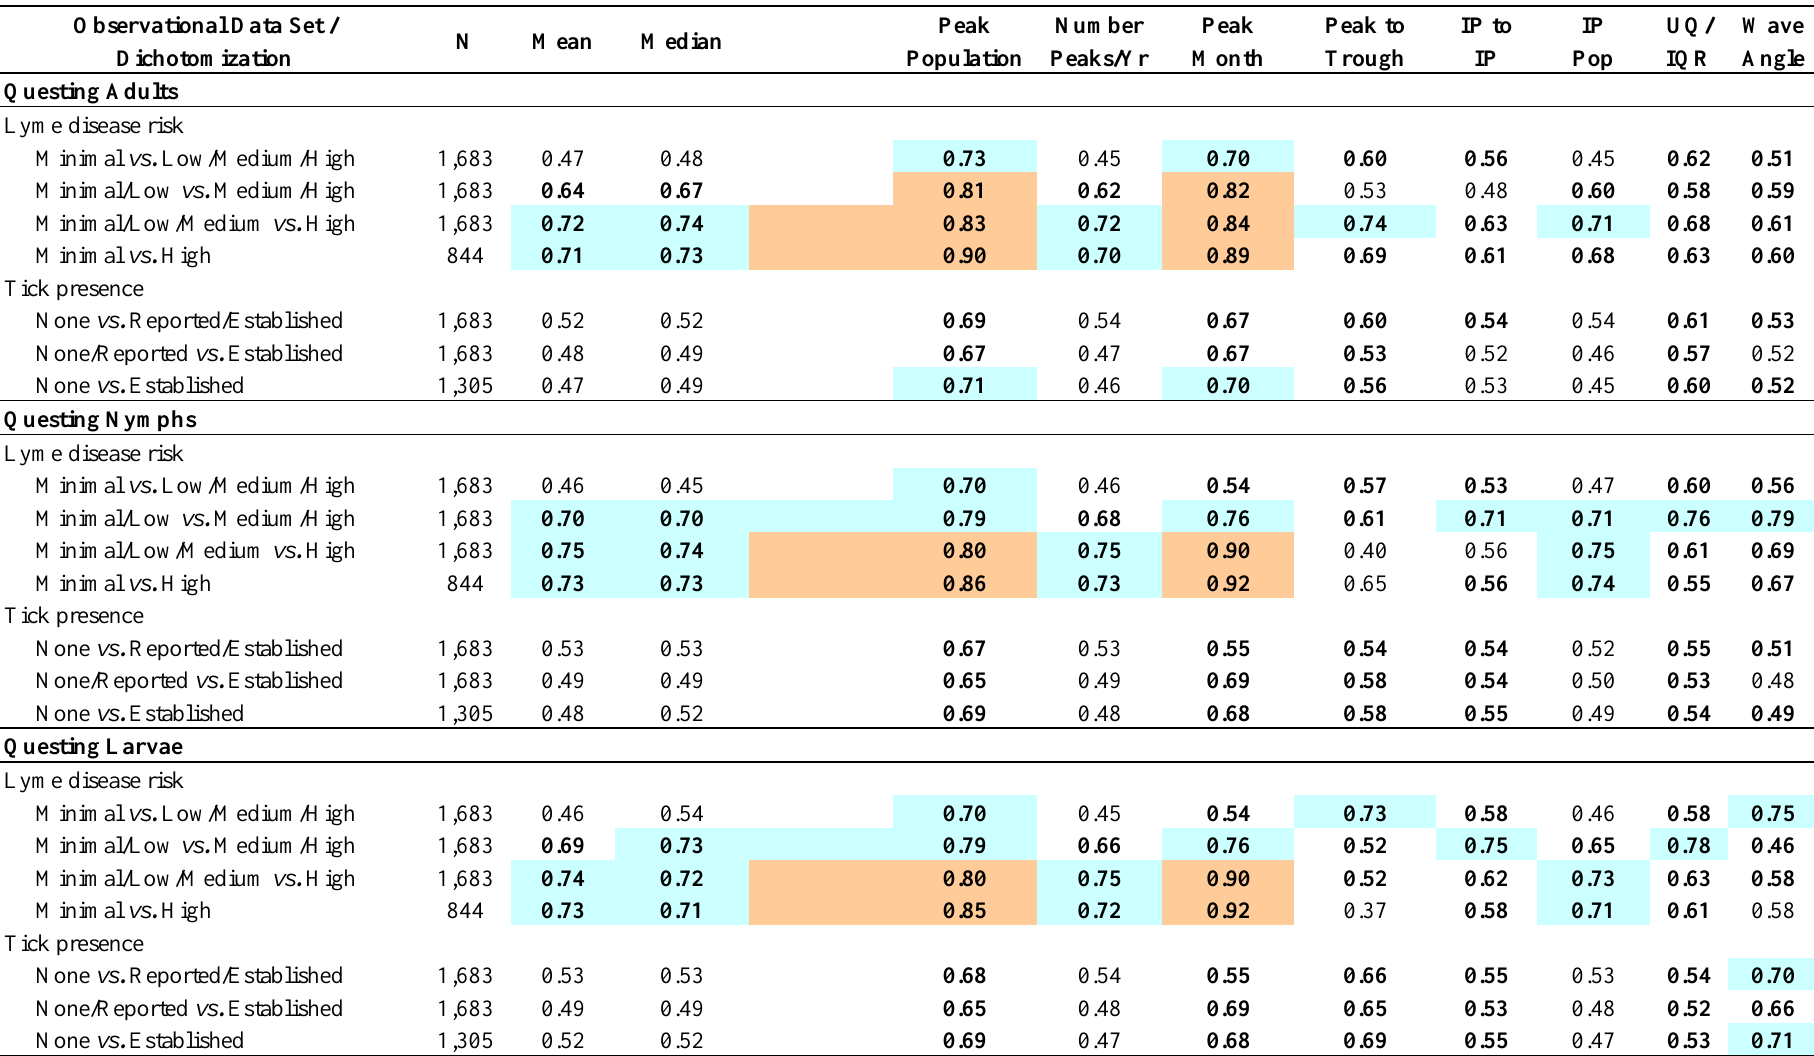
Table 3. Area under the receiver operating characteristic curve (AUC) analysis comparing dynamic population features (DPFs) to observed Lyme disease incidence and tick